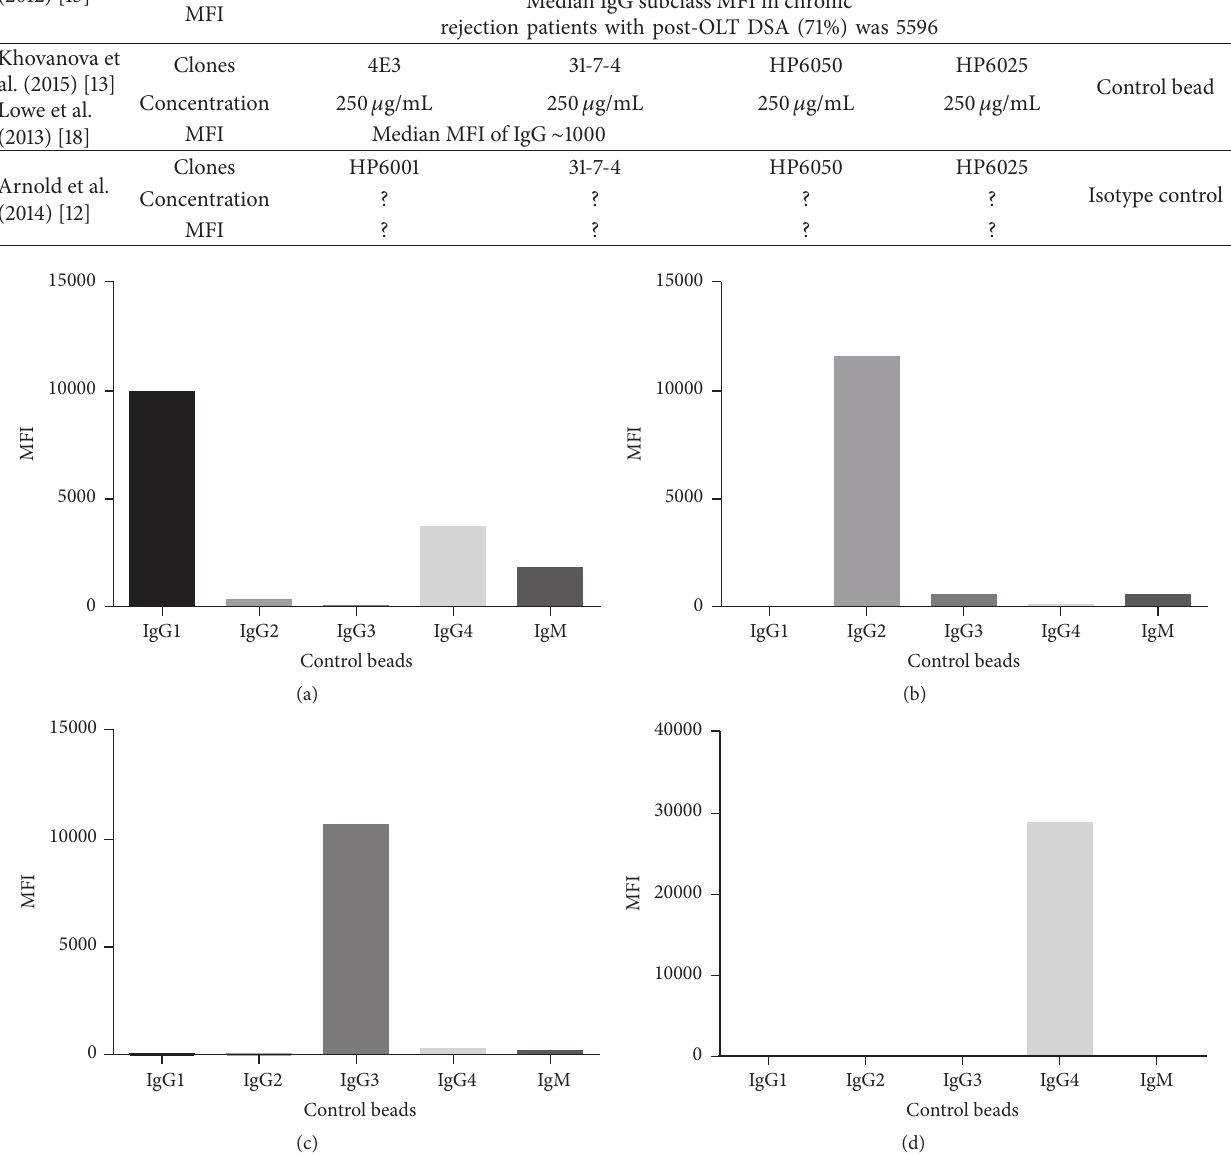
Figure 2: PE-conjugated secondary antibodies for IgG subclass detection. The control beads were incubated with negative control serum, washed, and then detected with subclass-specific antibodies ((a): IgG1-PE; (b): IgG2-PE; (c): IgG3-PE; (d):